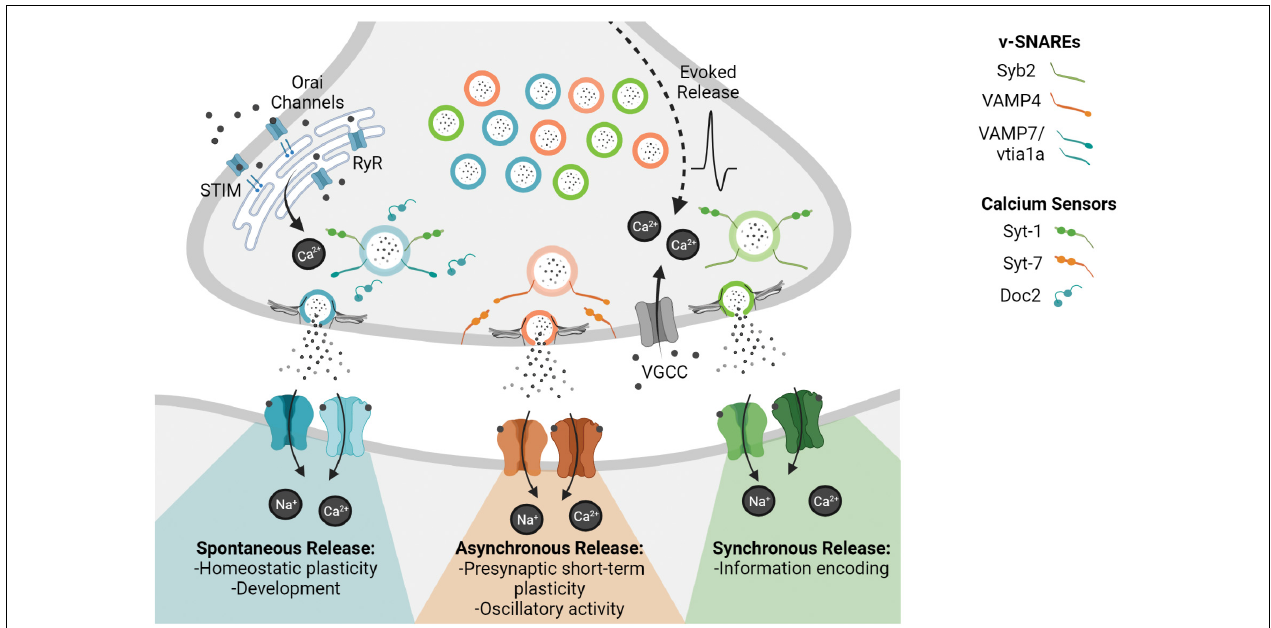
FIGURE 1 | This figure depicts the different modes of neurotransmission and their distinct downstream signaling pathways. Synchronous release transmits precise timing information across the synapse enabling information transfer with fidelity, whereas asynchronous release is thought to regulate short term plasticity and oscillatory activity. In contrast, spontaneous release is action potential independent although it may rely on alternative calcium sources, such as endoplasmic reticulum (ER) mediated calcium via ryanodine receptors (RyR) or store-operated calcium entry via Orai channels activated by the ER calcium sensor STIM. Spontaneous release is thought to play a role in synapse development as well as homeostatic synaptic scaling shaping synaptic